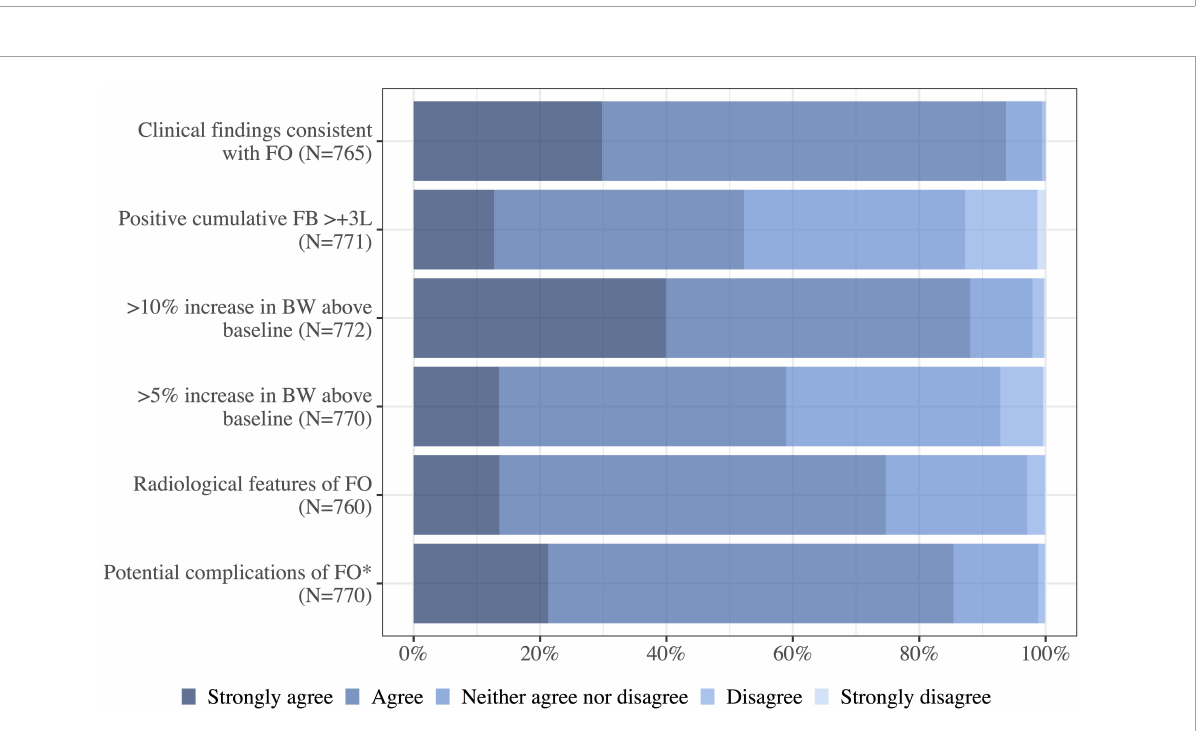
FIGURE4 I agree that the following features support the diagnosis of fluid overload in a critically ill patient. FB, fluid balance; FO, fluid overload; BW, body weight; N, number of respondents to the question. ∗ Presence of potential complications of fluid overload, e.g., increasing oxygen requirements, difficulty weaning from invasive ventilation, intraabdominal